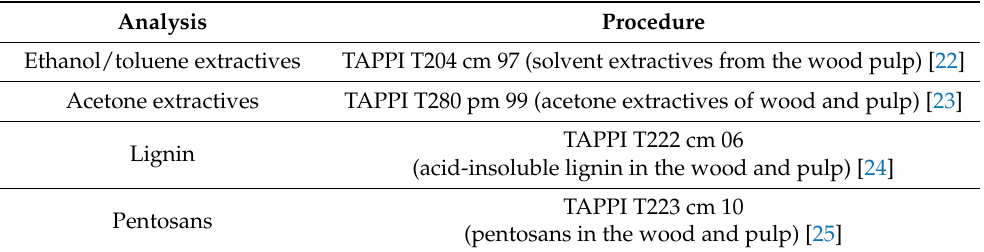
Table 1. Standards used for chemically analyzing the wood of Eucalyptus grandis × Eucalyptus urophylla.